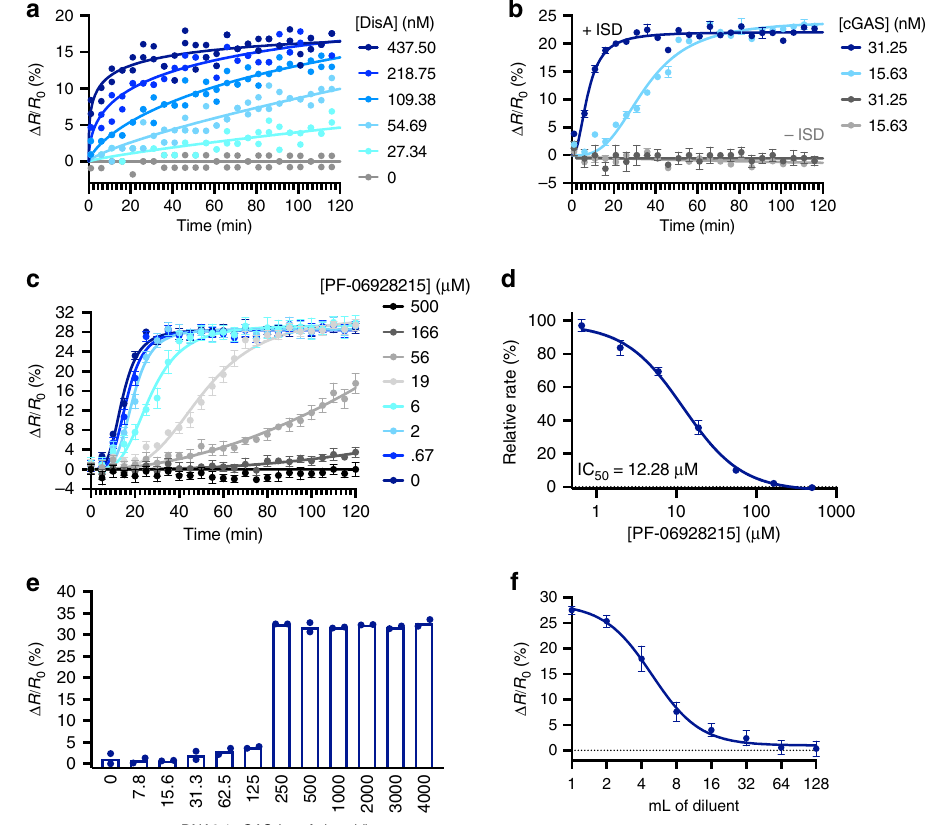
Fig. 2 Real-time measurement of CDN synthesis and determination of CDN levels from cellular extracts. a DisA enzyme activity assay time course in the presence of increasing concentrations of the 3 ’ 3 ’ -c-di-AMP cyclase DisA using BioSTING. b cGAS activity assay in the presence of indicated concentrations of recombinant cGAS with or without Interferon Stimulatory DNA (ISD) using BioSTING. c cGAS activity assay measuring 2 ’ 3 ’ -cGAMP production in the presence of fi xed cGAS and ISD concentrations with increasing concentrations of the cGAS inhibitor PF-06928215 using BioSTING. d Reaction linear rates calculated from panel c plotted versus PF-06928215 concentration and fi t to IC50 curve (Prism 8). e BioSTING FRET response in the presence of methanol extracted cGAMP from HEK293T cells transfected with increasing concentrations of pCDNA3.1-cGAS. f BioSTING FRET response over two-fold serial dilutions of cGAMP methanol extracts from HEK293T cells transfected with 5 µ g of pCDNA3.1-cGAS. In panels a and e , individual data points of n = 2 biological replicates are shown. In panels b – d and f , data are presented as mean ± s.d. of n = 3 ( b , f ) or n = 8 ( c – d ) biological